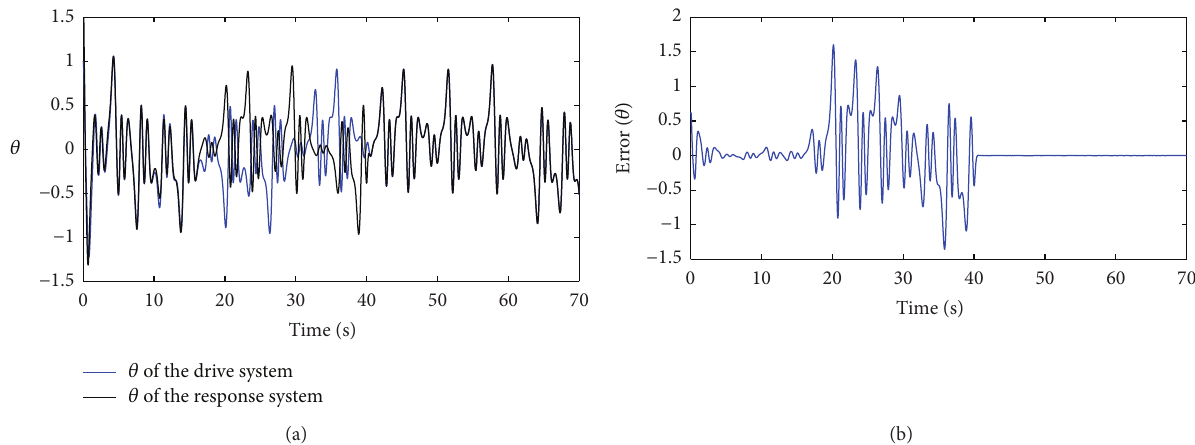
Figure 9: Simulation results of 𝜃 and error trajectories of synchronized chaotic gyros: (a) trajectories of 𝜃 of drive and response systems, (b) error behavior of 𝜃